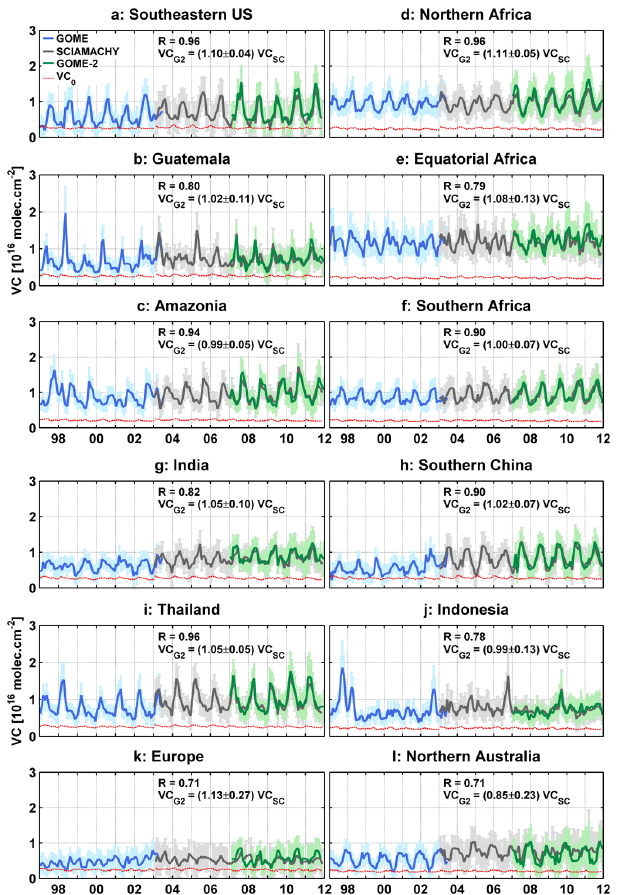
Fig. 12. Time series of monthly and regionally averaged H 2 CO ver- tical columns retrieved from GOME (in blue), SCIAMACHY (in grey) and GOME-2 (in green). The value of the reference sector correction is shown in red as an indication of the detection limit of the observations. The limits of the regions are shown in Fig. 9. The correlation values and regression lines between SCIAMACHY and GOME-2 observations are given in the inset of each plot for the period